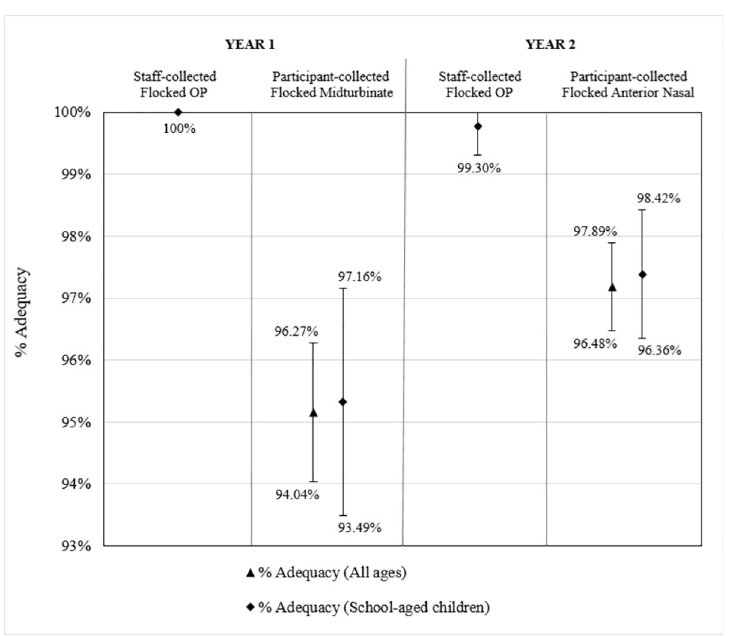
Fig 4. Adequacies of staff- and participant-collected respiratory specimens. Bars present the 95% confidence intervals for the percentage of adequate samples (Ct < 38) of (from left to right) staff-collected oropharyngeal (OP) specimens from school-aged children in Year 1 using Copan FLOQSwabs ™ flocked swabs, participant-collected midturbinate specimens from participants of all ages in Year 1 using Copan FLOQSwabs ™ flocked midturbinate swabs, participant-collected midturbinate specimens from school-aged children (ages 4–18) in Year 1 using Copan FLOQSwabs ™ flocked midturbinate swabs, staff-collected OP specimens from school-aged children in Year 2 using Copan FLOQSwabs ™ flocked swabs, participant-collected anterior nasal specimens from participants of all ages in Year 2 using Puritan Sterile Foam Tipped Applicators, and participant-collected anterior nasal specimens from school-aged children in Year 2 using Puritan Sterile Foam Tipped